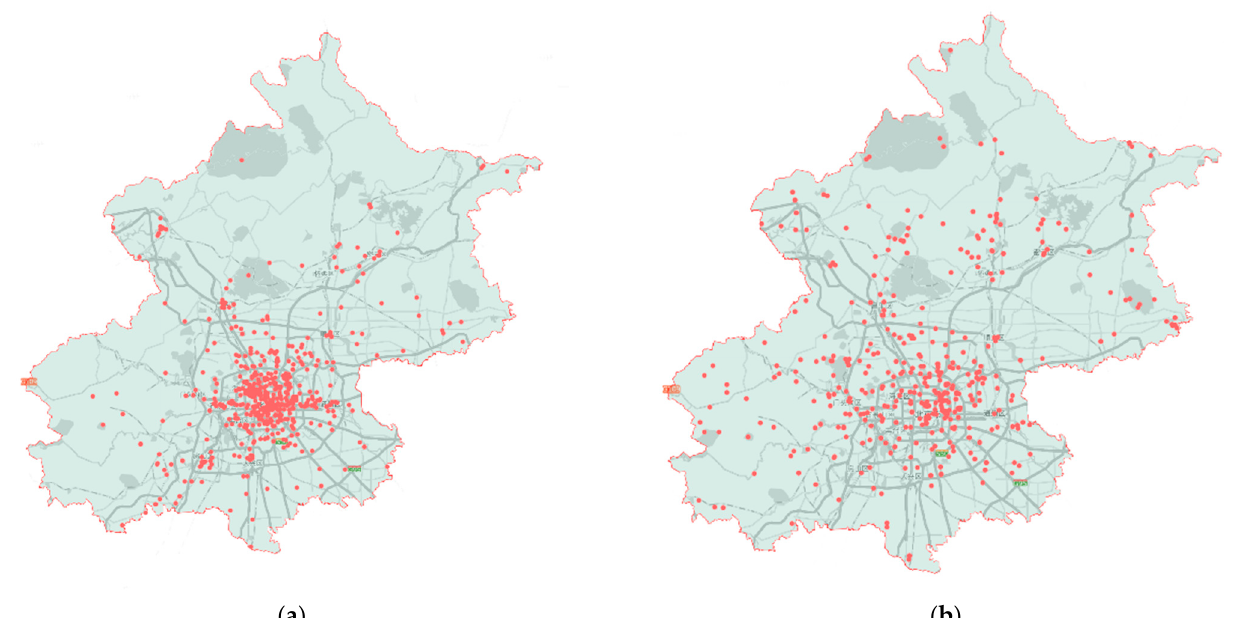
Figure 9. Sentiment analysis chart (during the outbreak).